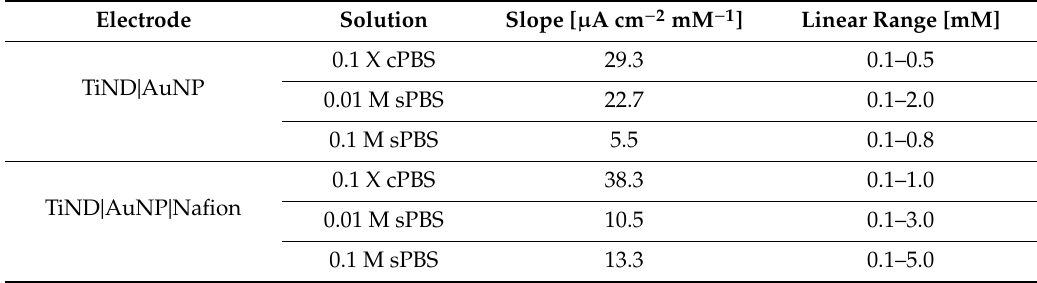
Table 4. Comparison of slopes and linear ranges of bare and coated TiND | AuNP electrodes in di ff erent